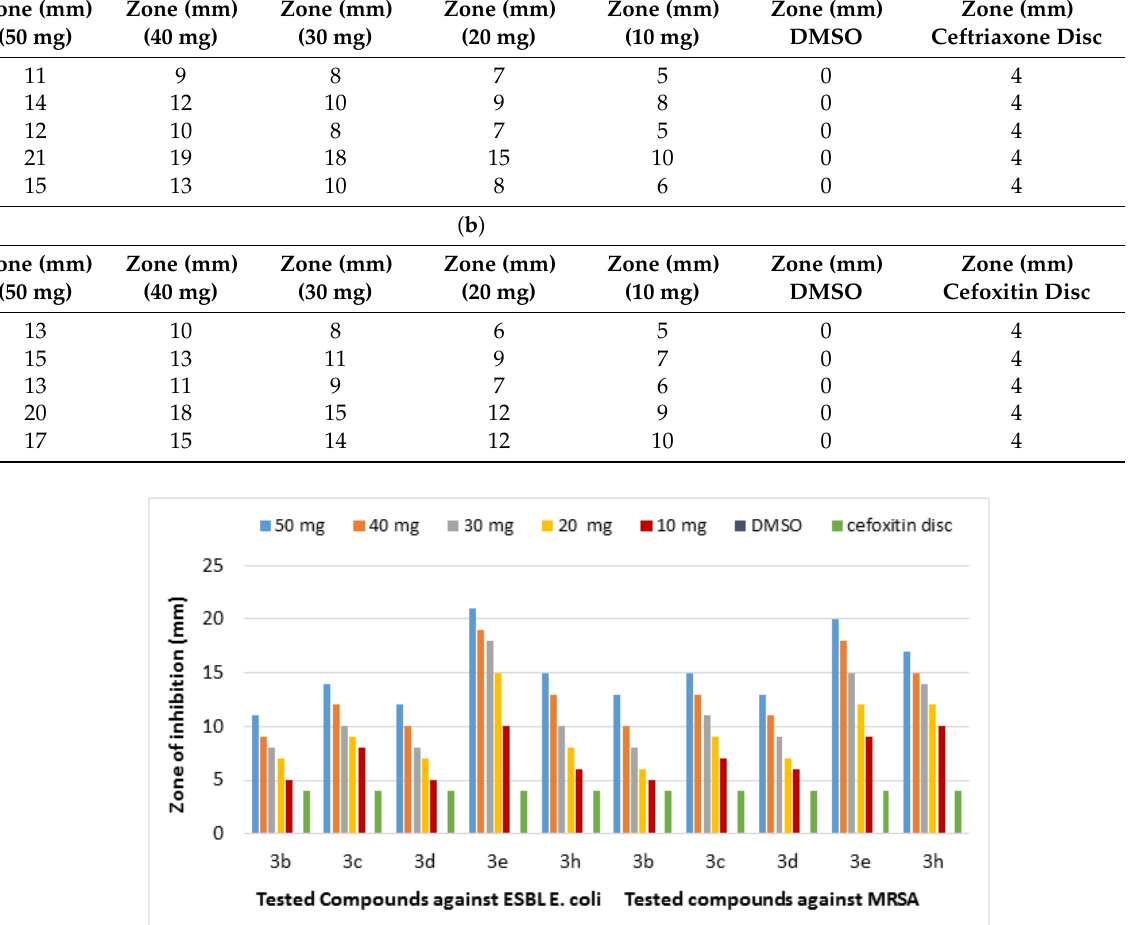
Table 3. ( a ): Agar well dispersion values of the active compounds against ESBL producing E. coli. ( b ): Agar well dispersion values of active compounds against MRSA. ( a )